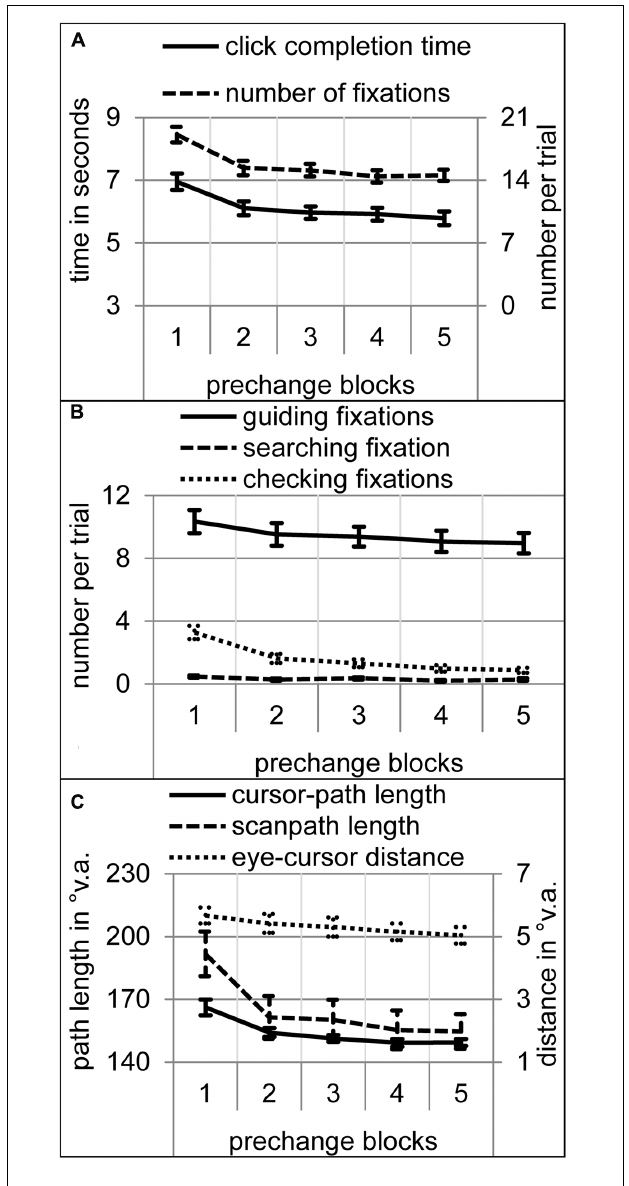
FIGURE 2 | Performance and eye movement measures over the course of the five prechange blocks. Error bars represent standard error of the means. (A) Click completion time in seconds and number of fixations per trial. (B) Number of searching, guiding, and checking fixations per trial. (C) Cursor-path and scanpath length as well as eye-cursor distance in ◦